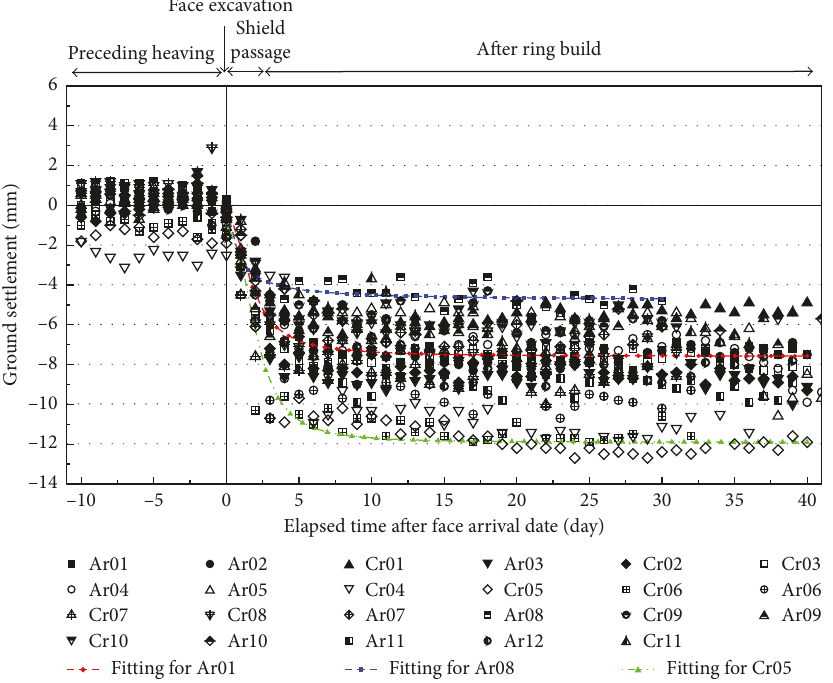
Figure 6: Variation of settlement above the tunnel crown with TBM drive sequences (down-track).